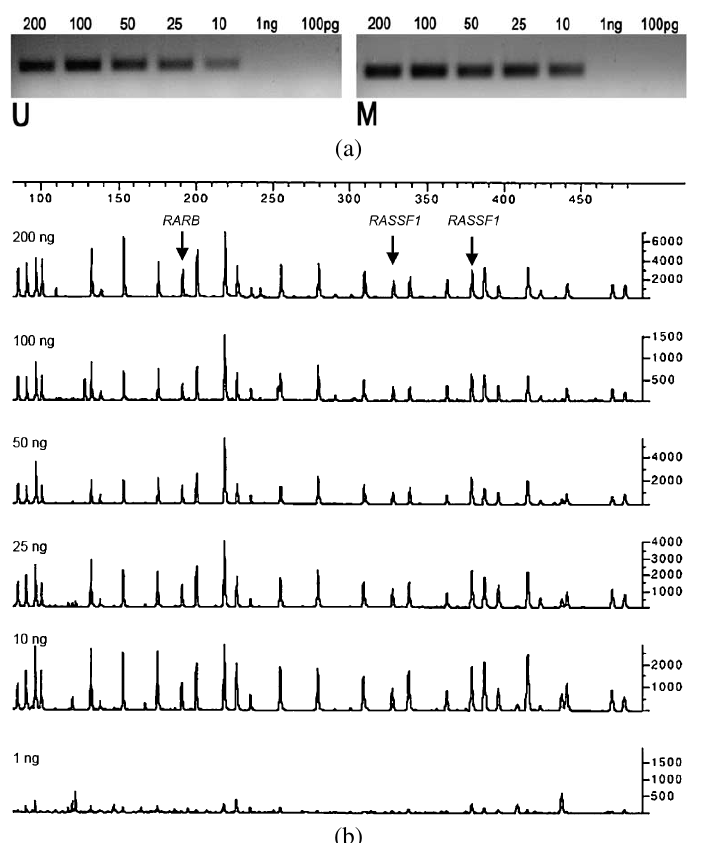
Fig. 3. Performance of different methylation assays in decreasing amounts of cell line DNA. (a) MSP for RARB on serial dilutions of MCF10A human breast epithelial cell line DNA. Amount of input DNA is indicated. MSP is feasible down to a minimum of 10 ng DNA. The left panel shows the results for the unmethylated primer set (U) and the right panel for the methylated primer set (M). (b) MS-MLPA on serial dilutions of MCF10A breast epithelial cell line DNA. Results for ME001-C1 kit including RARB probe (193 nt) and two RASSF1 probes (328 and 382 nt). Amount of input DNA is indicated. Capillary electrophoresis results for digested samples. MS-MLPA is feasible down to a minimum of 10 ng DNA. (c) QM-MSP for RARB on serial dilutions of MCF10A breast epithelial cell line DNA. Quantitative PCR methylation curves are shown. From left to right: 100, 10 and 1 ng of input DNA for NaBi treatment. The distances between the three curves are not equal. Probably, more DNA is lost during column purification after NaBi treatment and amplification in multiplex PCR is less efficient for the higher DNA